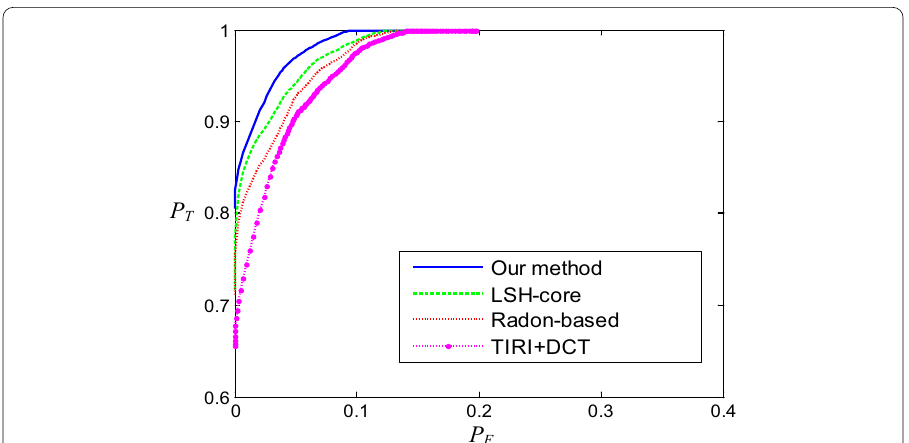
Fig. 5 ROC curves of performances for four hashing methods. Here shown are the performance comparison of four hashing methods in form of ROC curves. The false positive rates and true positive rates are the x -axis and y -axis, respectively. Besides our method, three other methods, i.e., LSH-core, Radon-based and TIRI are included. The higher the curve is, the better the hashing method in terms of robustness and security